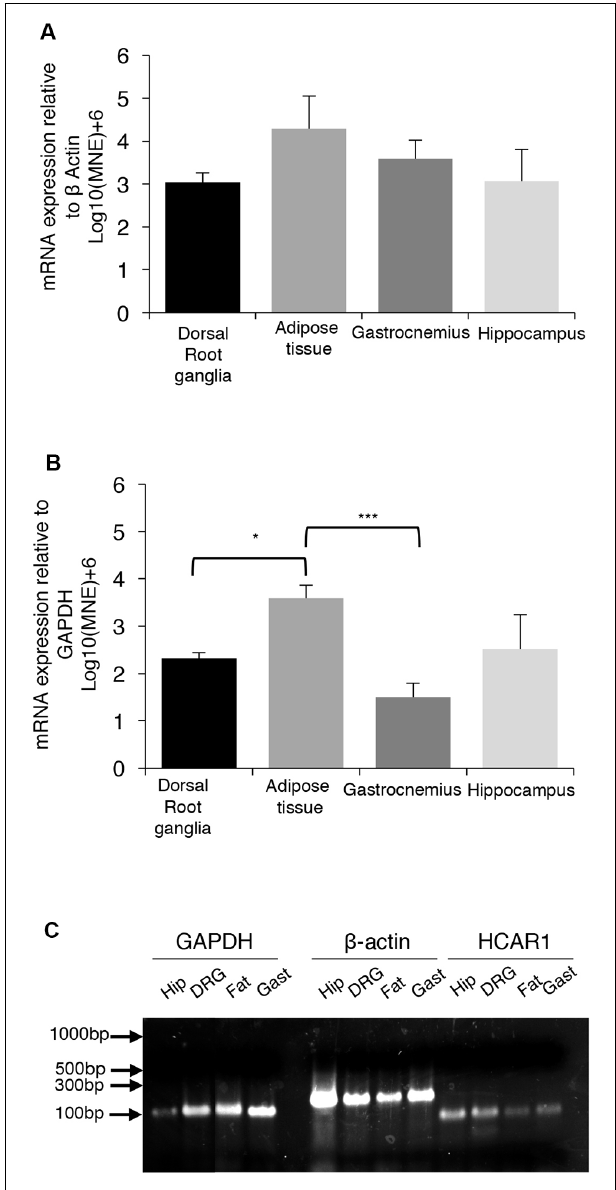
FIGURE 7 | mRNA expression of HCAR1 across tissue samples ( n = 4). (A) Mean expression of HCAR1 normalized relative to β -actin, in dorsal root ganglia (DRG), adipose tissue, gastrocnemius muscle, and brain tissue (hippocampus). Differences in relative expression were not significant. (B) The mean expression of HCAR1 normalized relative to GAPDH suggested that content in adipose tissue may be higher than in the DRG and hippocampus. (C) Gel separation and molecular weight of PCR products of HCAR1 ( ∼ 82 bp) for Hip (Hippocampus), DRG (Dorsal root ganglia), Gast (Gastrocnemius) in lanes 9–12. Products for GAPDH ( ∼ 109 bp) and b-actin ( ∼ 149 bp) in lanes 1–4 and 5–8, respectively; these are both housekeeping genes commonly used to normalize expression levels. * P < 0.05, *** P <